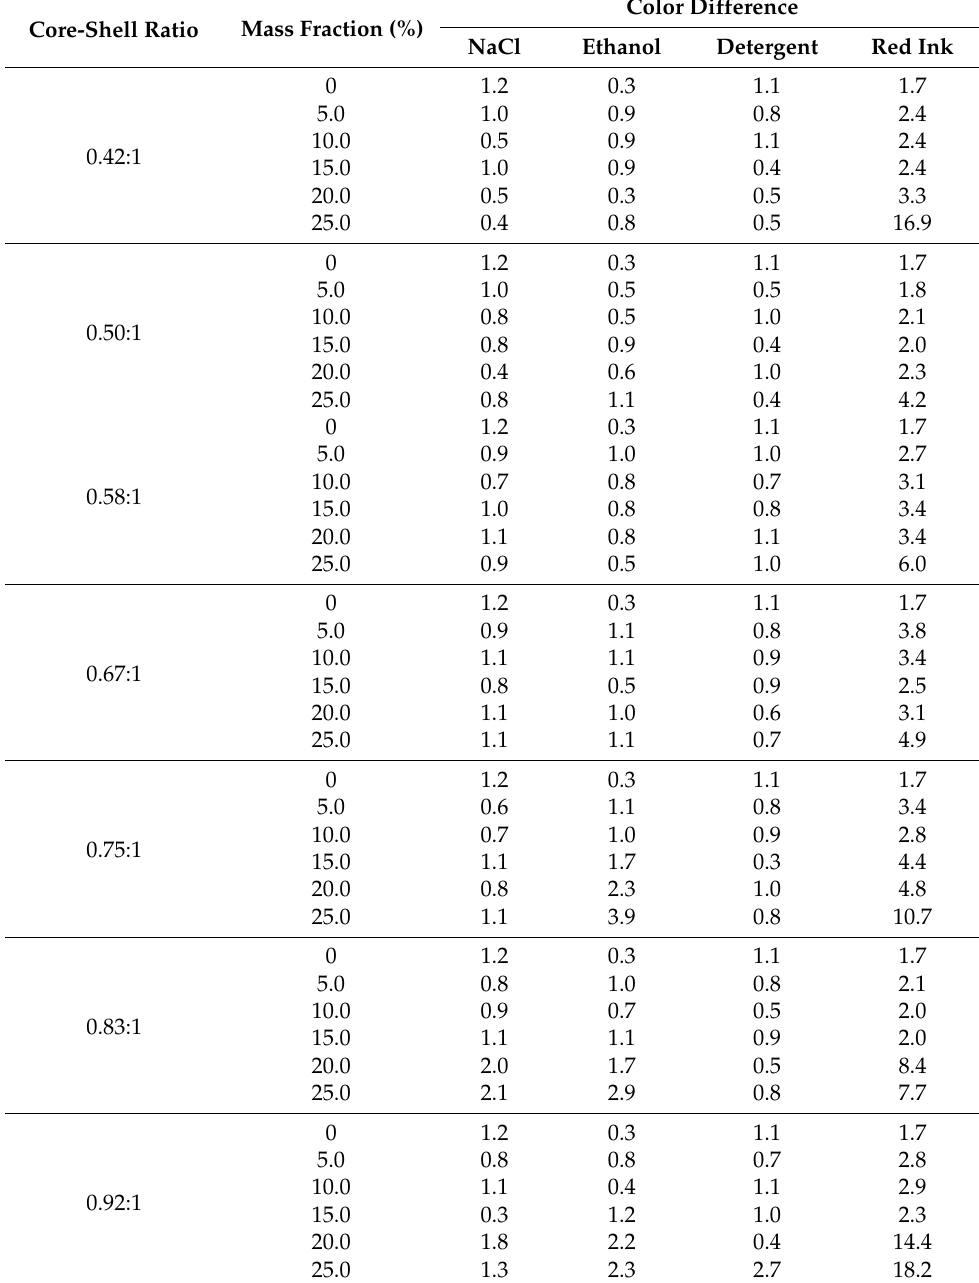
Table 7. Effect of microcapsule concentration and core-shell ratio on the color difference of painted surfaces after exposure to different